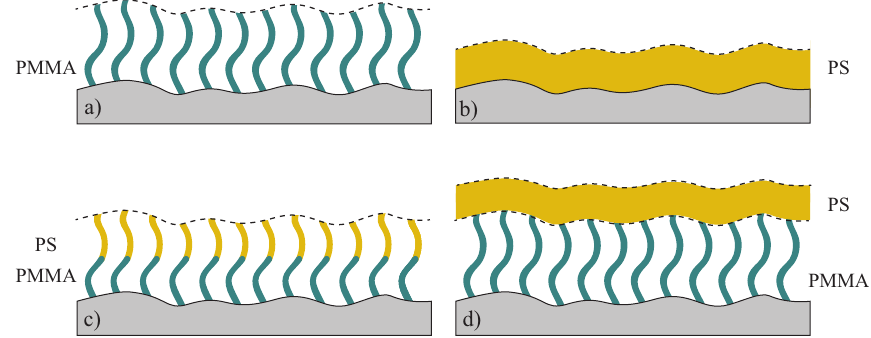
Figure 4. Schematic overview of samples, prepared and characterized in this work. All polymer films were coated on Si-substrates. The dashed lines illustrate the roughness profiles of polymer films, which are correlated to the profile of the substrate. ( a ) PMMA brushes on a silicon substrate; ( b ) Spin-coated PS film; ( c ) PMMA- b -PS copolymer brushes; ( d ) PS film spin-coated on PMMA polymer